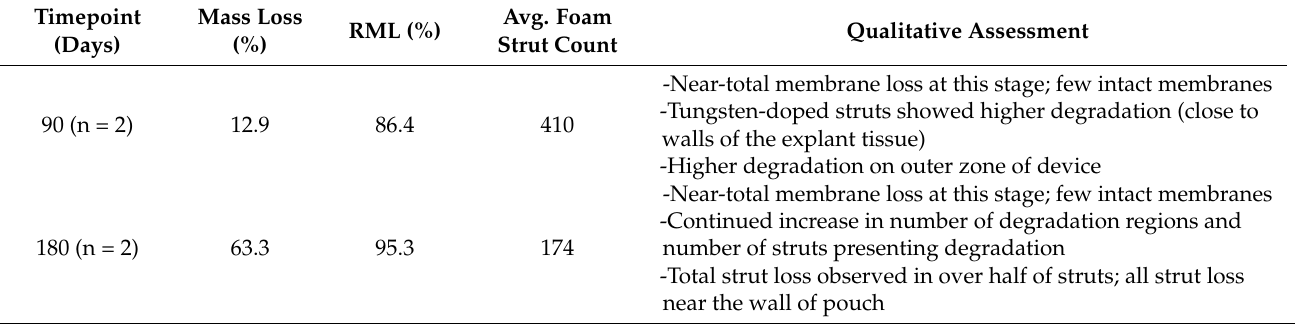
Table 6. Foam spheroid degradation quantification/qualification in a porcine sidewall pouch